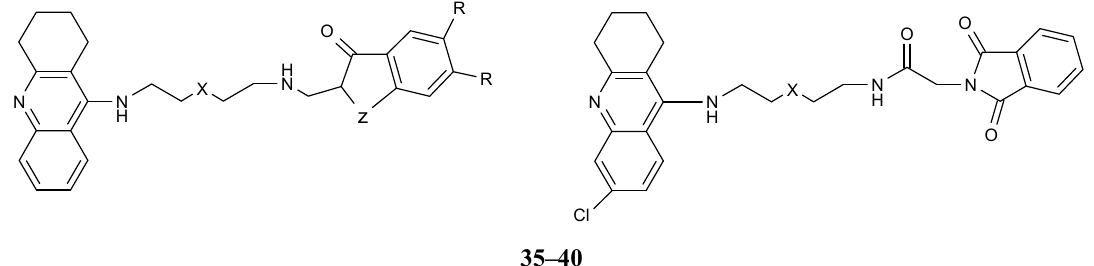
Figure 13. Tacrine-donepezil hybrids 35–40 and 41–46